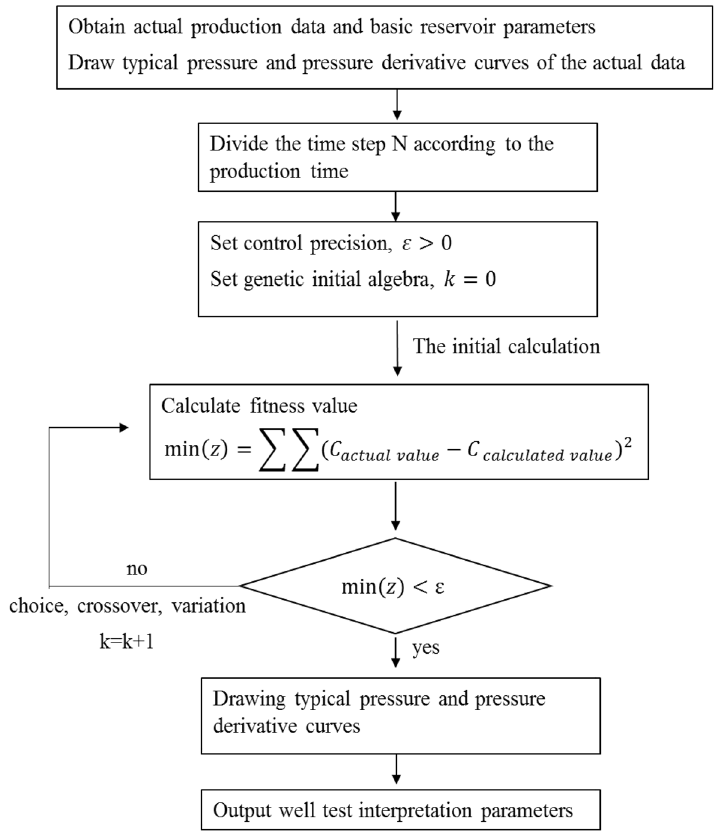
Figure 18. Curve fitting flow chart.